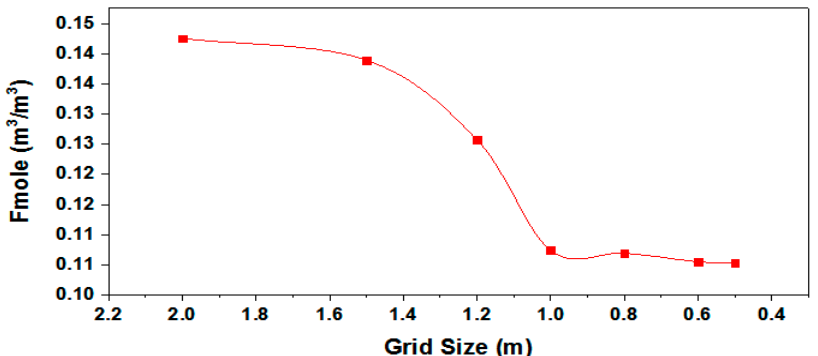
Figure 6. Dispersion mesh sensitivity study.